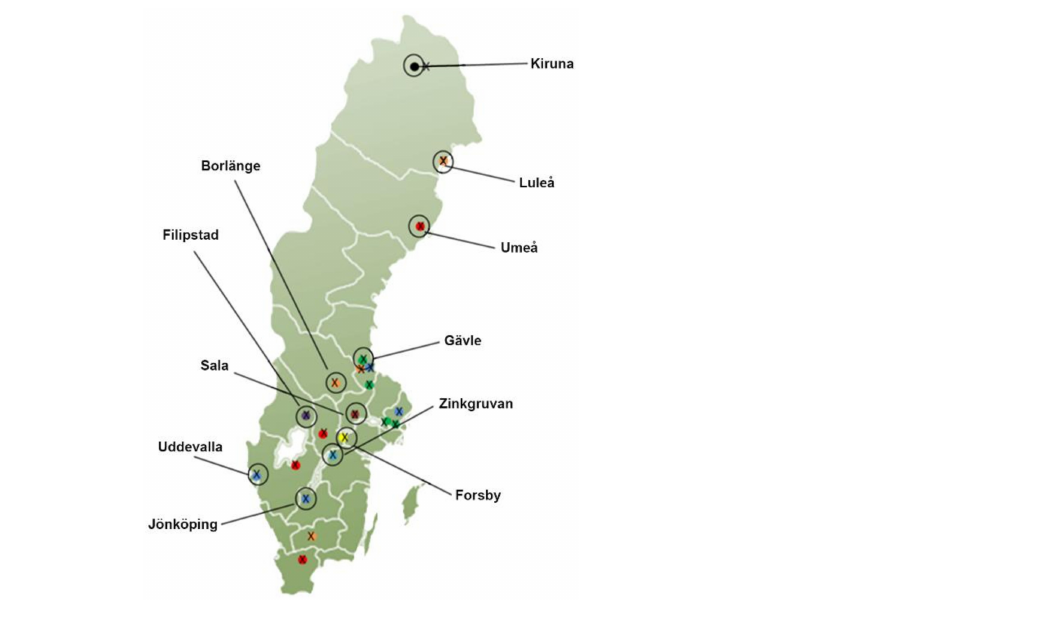
Figure 5. Location of the quarries tested in Sweden. Circles denote where the mobile VSI plant was set up, and the colored dots show where the material originated from.